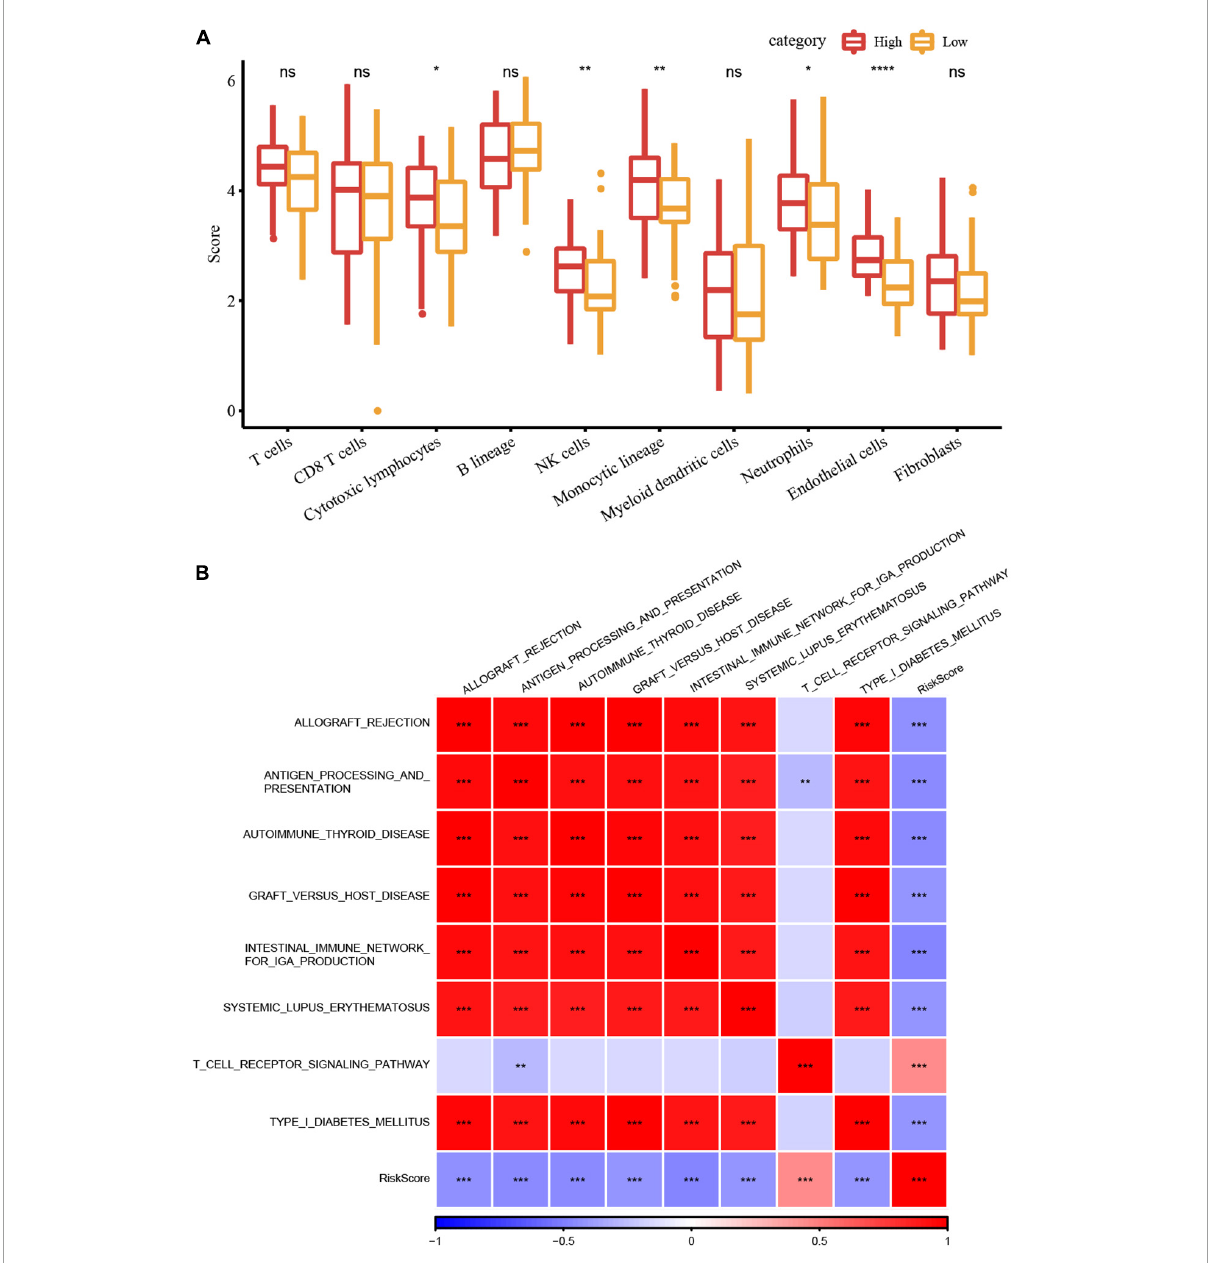
FIGURE6 RiskScore analysis of immune microenvironment and signaling pathways. (A) Differences in 10 different cell types predicted by the MCPcounter method between high- and low-risk groups; (B) Heatmap of the correlation analysis between risk scores and potential immune modulations (* P < 0.05; ** P < 0.01; *** P < 0.001; and **** P <